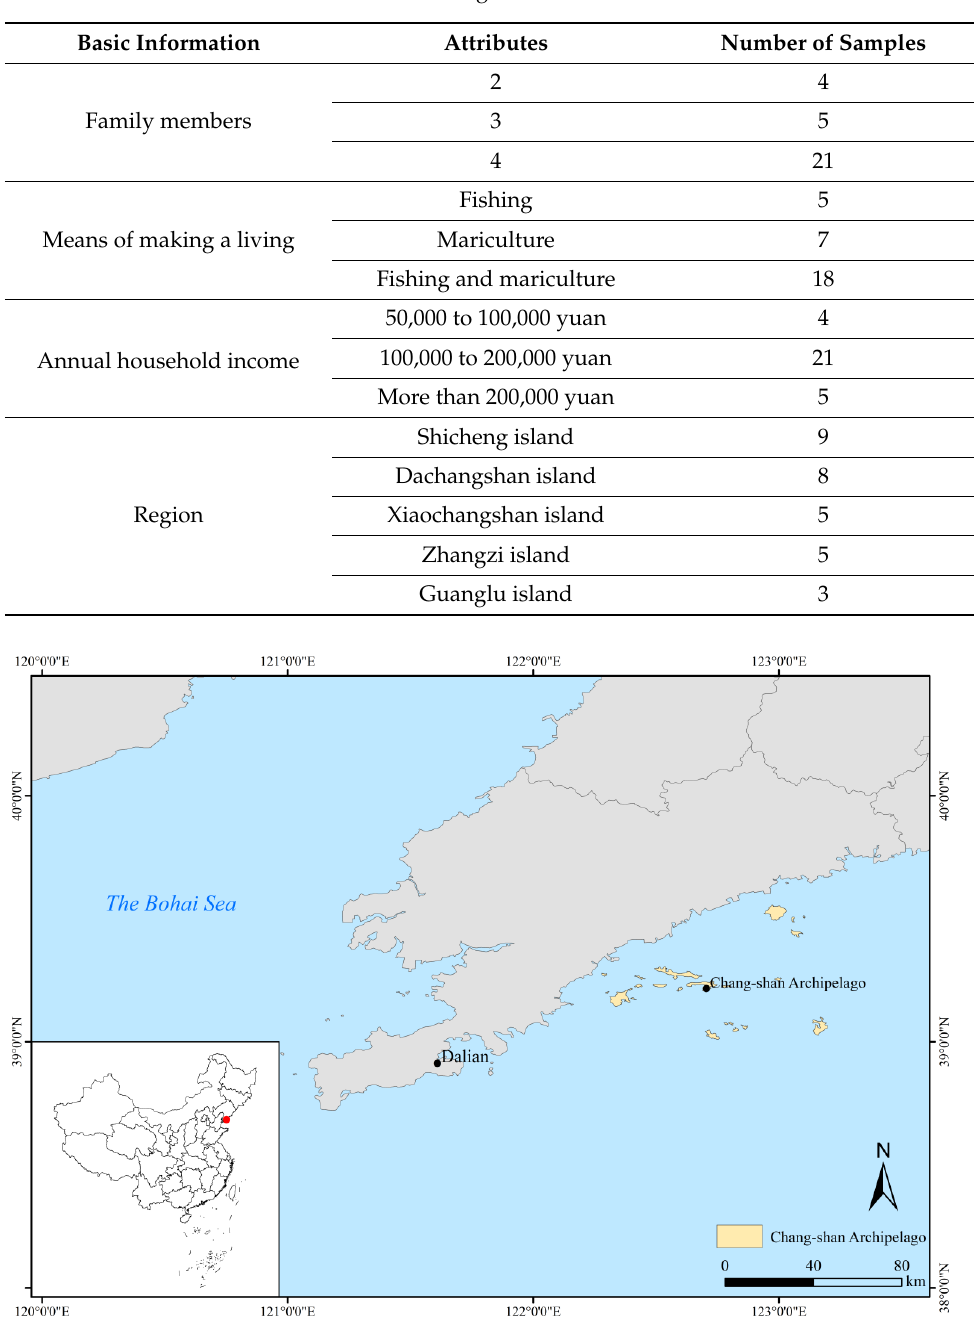
Figure 1. Location map of Chang-shan Archipelago.